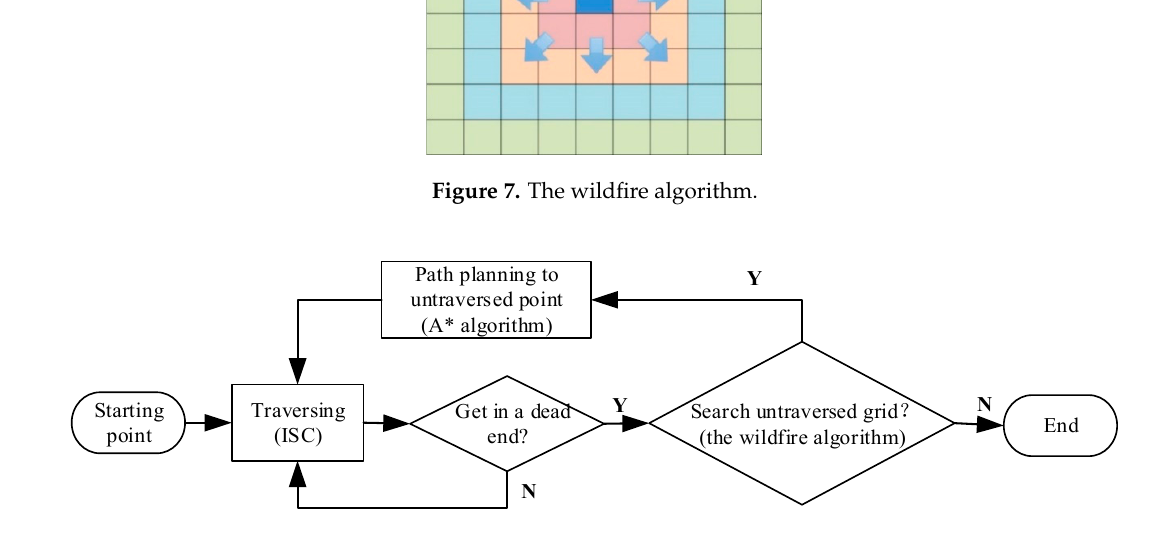
Figure 8. Process of the full-coverage traversal method.